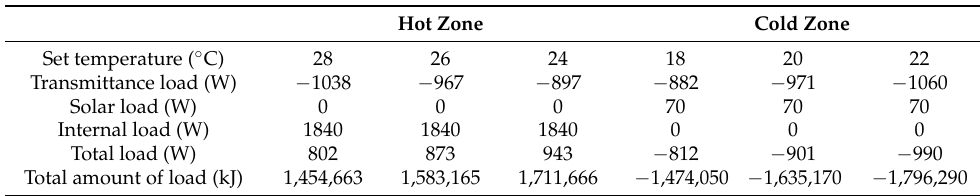
Table 5. Zone thermal load according to set point